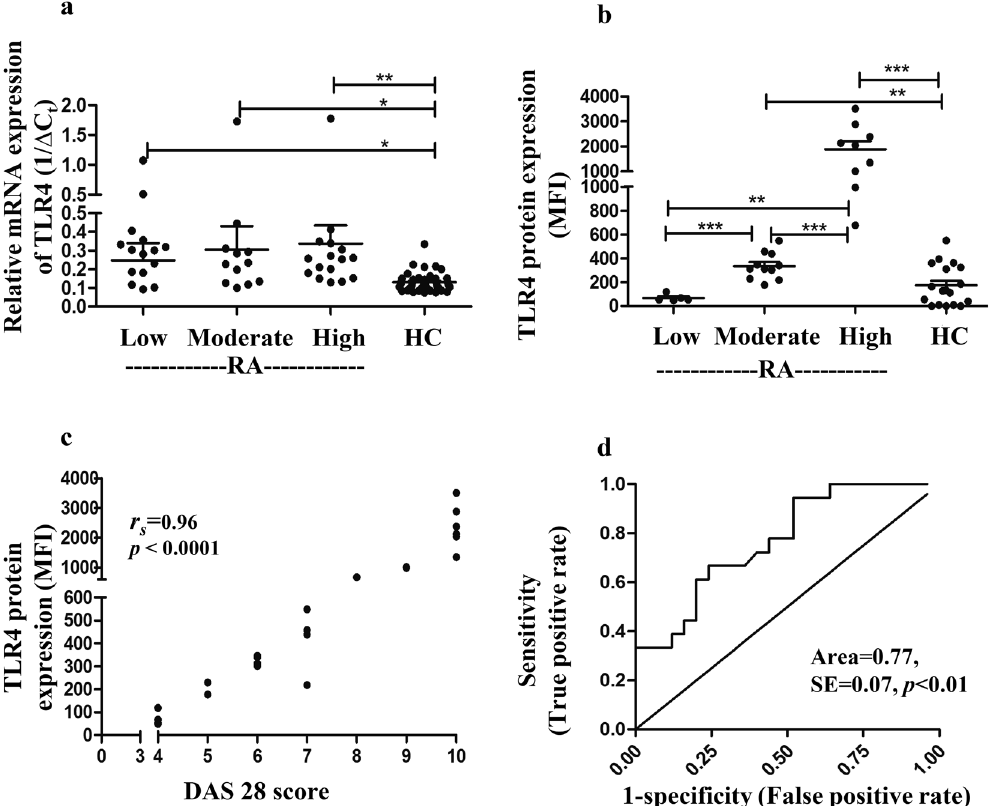
Figure 2. TLR4 expression by CD8 + T cells in RA patients at different disease activity states. ( a , b ) The scatter plots represent TLR4 mRNA and protein expression by CD8 + T cells of healthy controls (HC) and RA patients segregated according to low, moderate and high DAS28 scores. ( c ) The figure shows Spearman non- parametric correlation analysis of TLR4 protein (MFI) with DAS28 score. ( d ) ROC analysis for TLR4 protein expression in RA and HC samples. CD8 + T cells from 45 patients (DAS28: low = 16, moderate = 13, high = 16) and 42 controls were analyzed for TLR4 transcript analysis and CD8 + T cells from 25 patients (DAS28: low = 5, moderate = 11, high = 9) and 18 controls were analyzed for TLR4 protein analysis. Bars represent the mean ± SEM. * p < 0.05, ** p < 0.01, *** p < 0.001, SE = standard